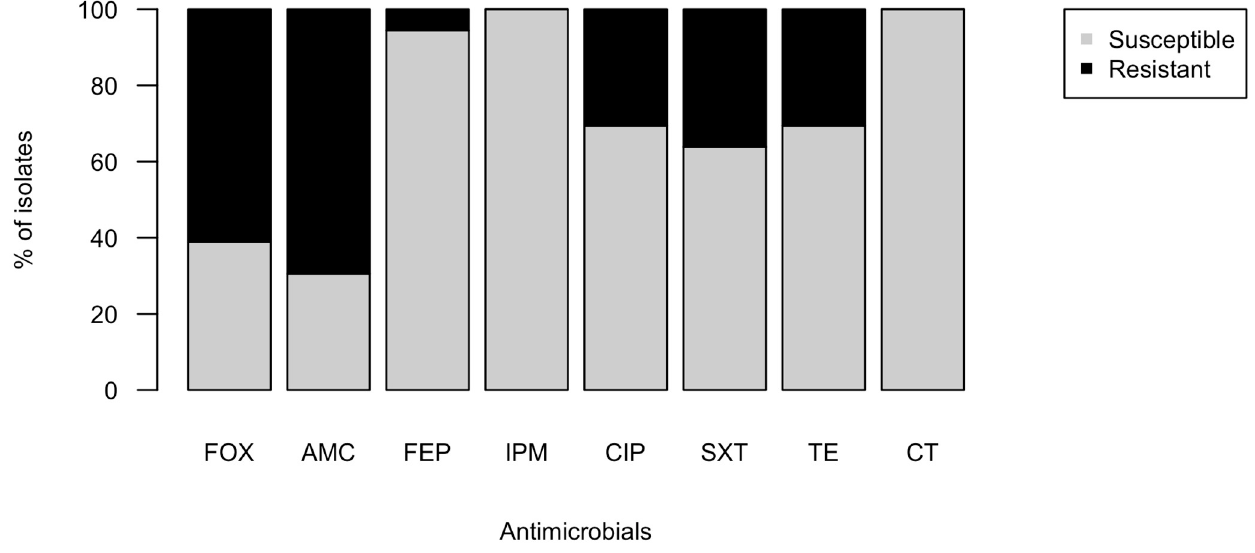
Figure 1. Proportion of environmental isolates resistant to common antibiotics. A total of 269 purple colonies were picked from modified mTEC plates of water samples and assayed for resistance to cefotaxime (CTX). A subset of the 97 CTXr isolates ( n = 36) was further tested for resistance to the antibiotics FOX, AMC, FEP, IPM, CIP, SXT, TE, and CT using disk diffusion assays. Resistant and susceptible classifications were determined by the diameters of the zones of inhibition based on CSLI standards. Table 2. Resistance phenotypes and cephalosporin MICs for CTX r isolates. Isolate